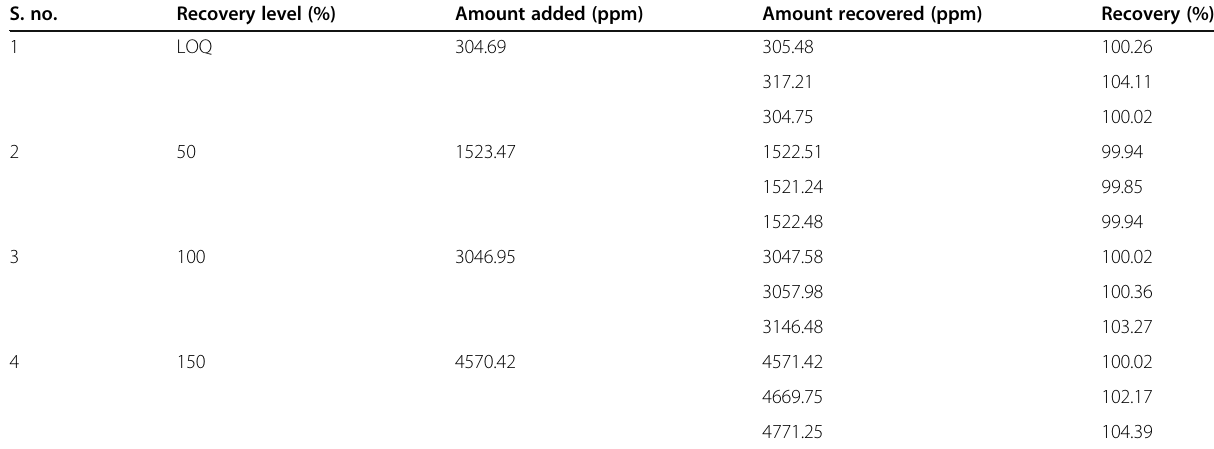
Table 8 Results of recovery study for methanol